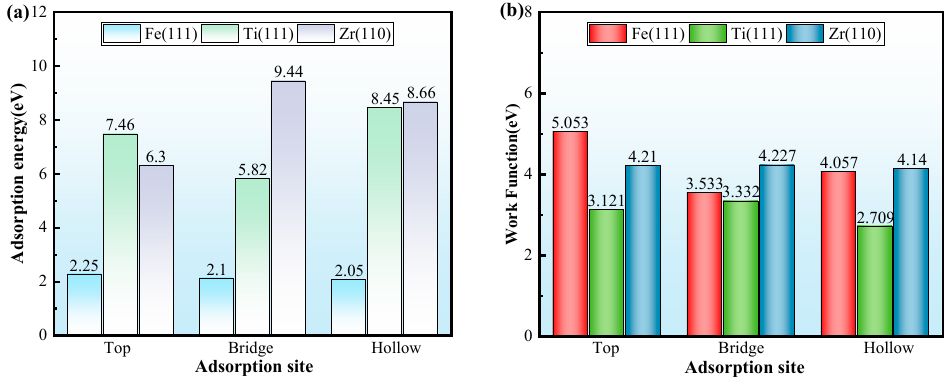
Figure 5. Adsorption energy ( a ) and work function ( b ) of Fe, Ti, and Zr by oxygen.